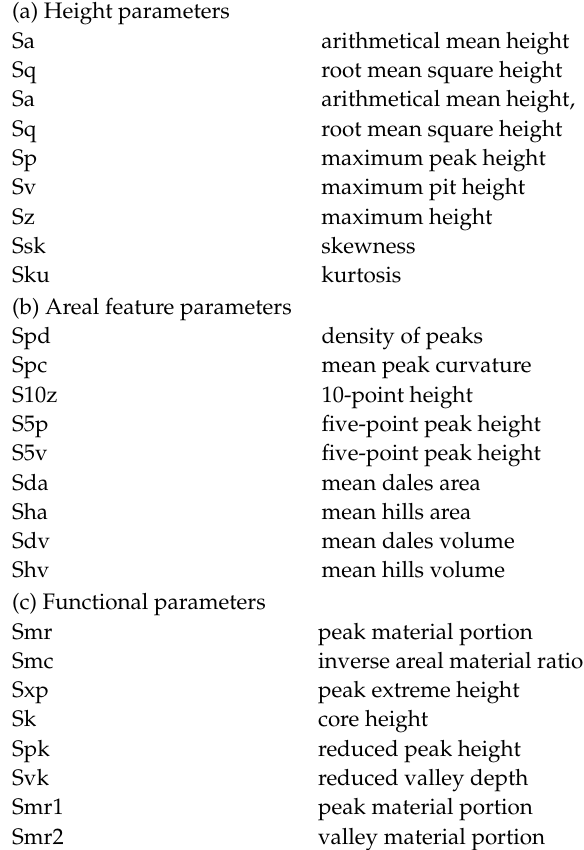
Curvature parameters- factor 1—build direct; Figure S27: ANOVA—Curvature parameters- factor 2— machining; Figure S28: ANOVA—Curvature parameters- both factors together; Figure S29: ANOVA— wavelet transformation- factor 1—build direct; Figure S30: ANOVA—wavelet transformation—factor 2—machining; Figure S31: ANOVA—wavelet transformation—both factors